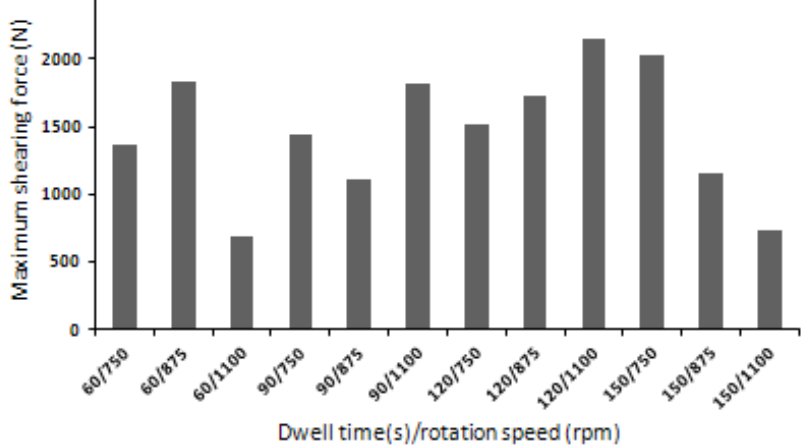
Figure 7: comparison diagram of the tensile / shear strength for the different FSSW welding